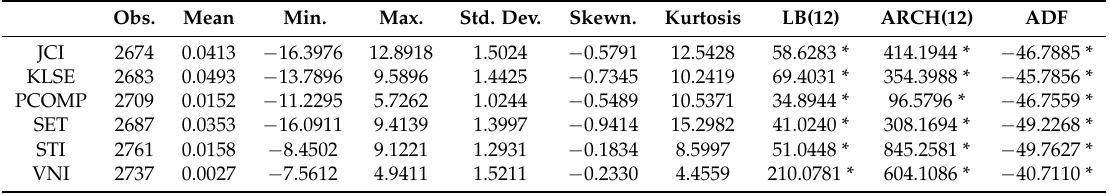
Table 1. Descriptive statistics of the log-returns for the six ASEAN stock indices in the period 1 July 2006–30 June 2017. Rejection of the null-hypothesis is displayed with asterisks (* 1% level of